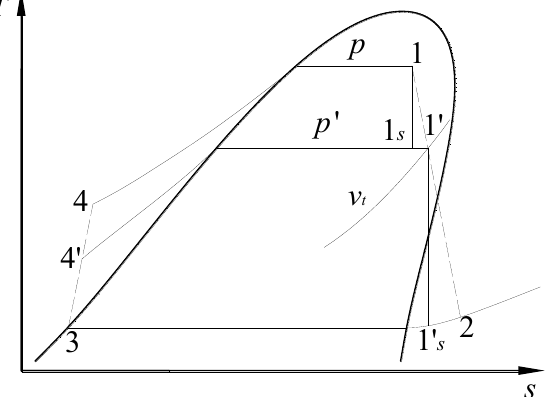
Figure 3. The sub-critical ORC with expansion process of Category